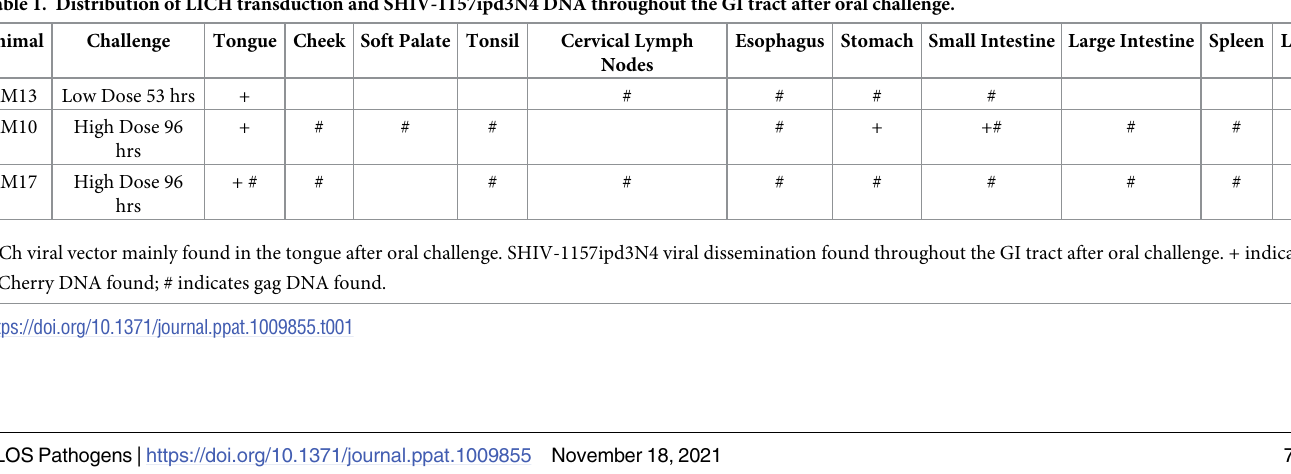
Table 1. Distribution of LICH transduction and SHIV-1157ipd3N4 DNA throughout the GI tract after oral challenge. Animal Challenge Tongue Cheek Soft Palate Tonsil